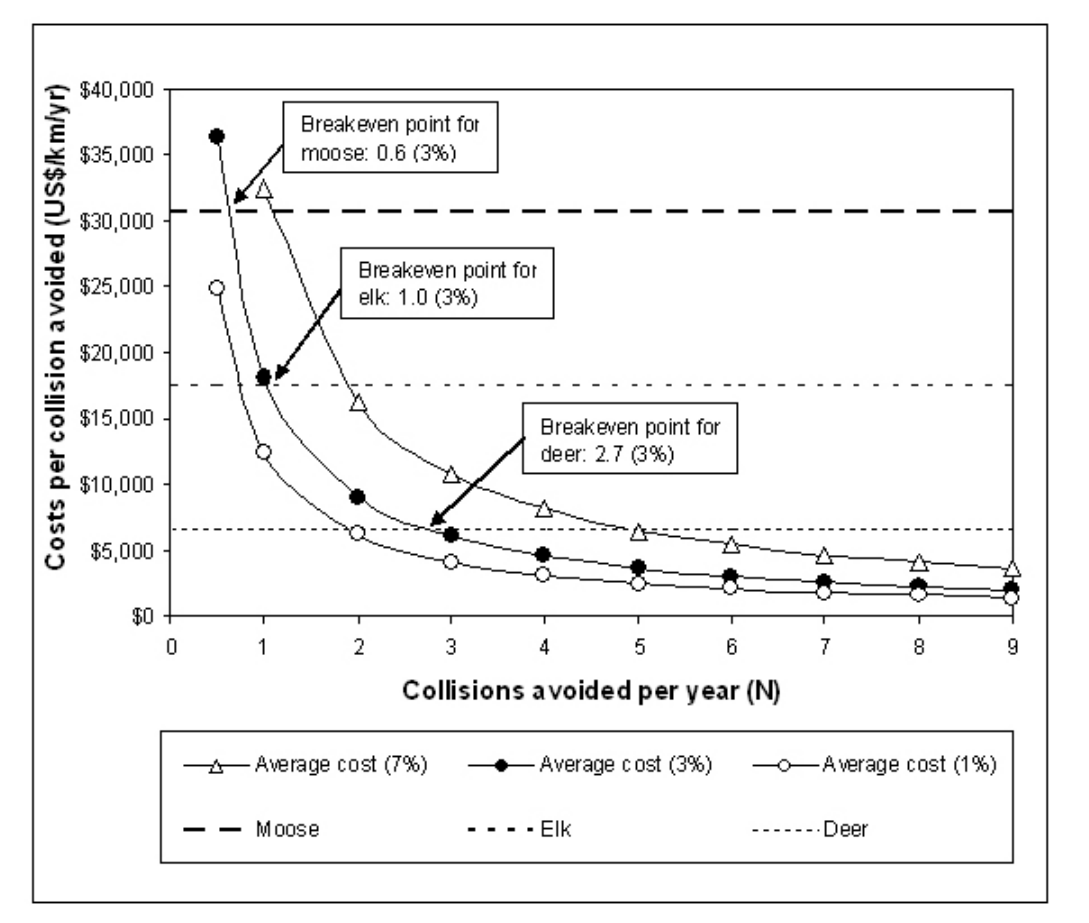
Fig. 7. The average costs per collision avoided per year for deer, elk, and moose for the mitigation measure fencing with underpasses (solid lines) (at 7%, 3%, and 1% discount rate) and the costs associated with the average deer–, elk–, or moose–vehicle collision (dotted lines) (all in real 2007